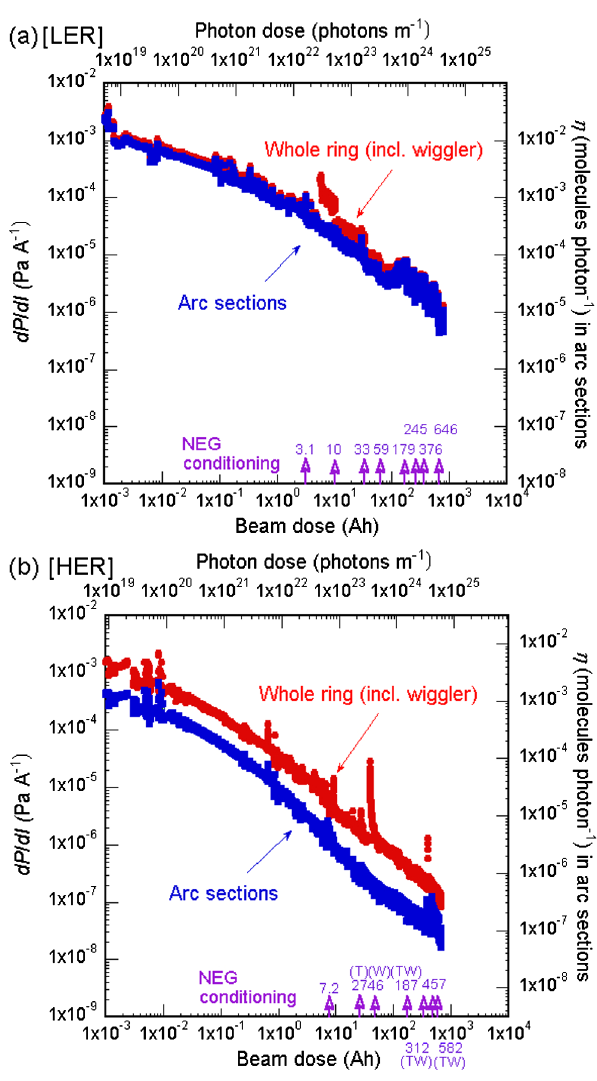
FIG. 4. dP=dI (Pa A − 1 ) and η (molecules photon − 1 ) in the arc sections as functions of the beam dose (Ah) and D (photons m − 1 ) in the arc sections for (a) the LER and (b) the